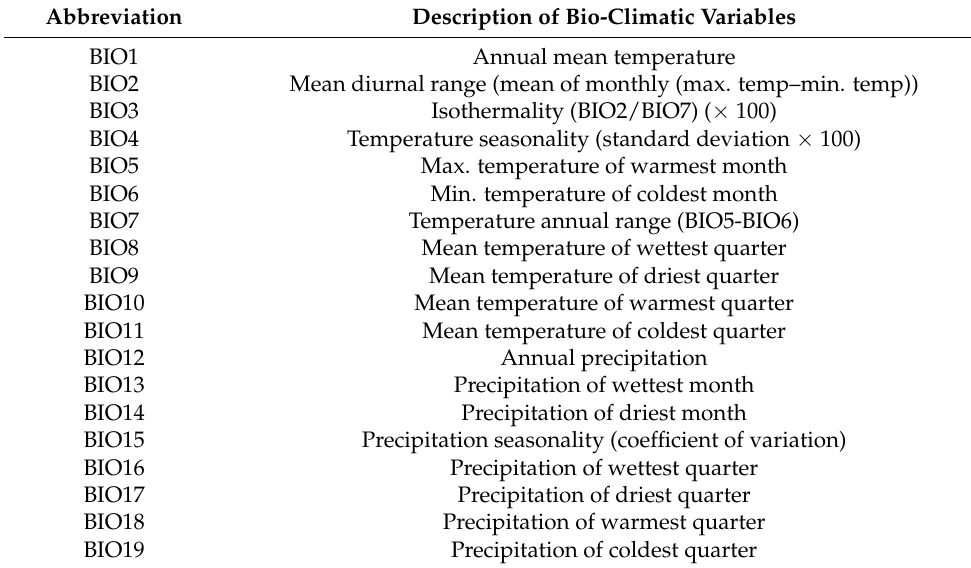
Table 5. Bio-climatic variables used for association